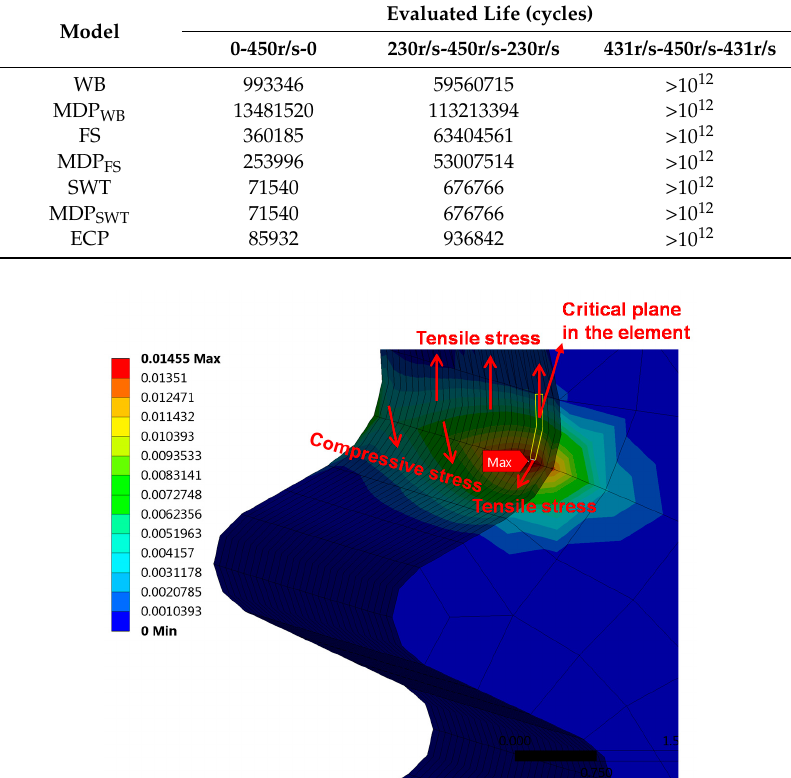
Figure 11. Stress analysis of the element with critical plane.